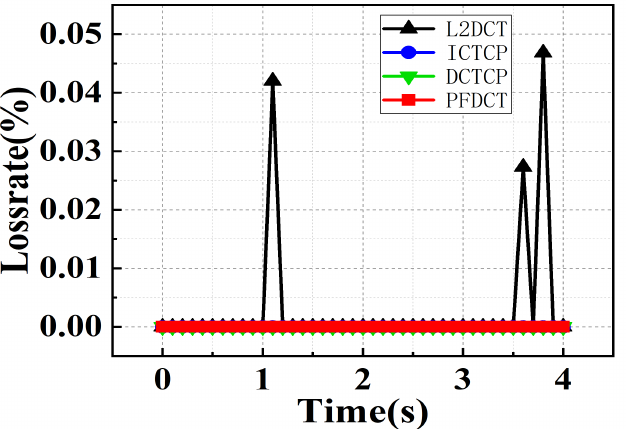
Figure 12. Loss rate comparison of multiple schemes in large-scale